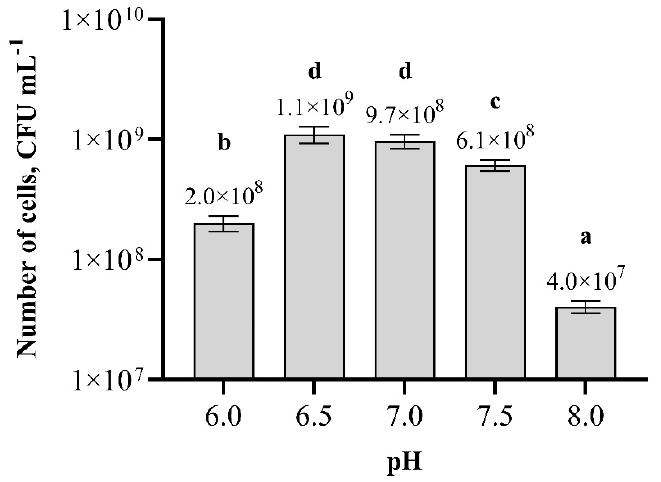
Figure 6. Effect of pH values on the biomass production of Paenibacillus sp. MVY-024. The values marked with the same letter have no significant difference at p ≤ 0.05.